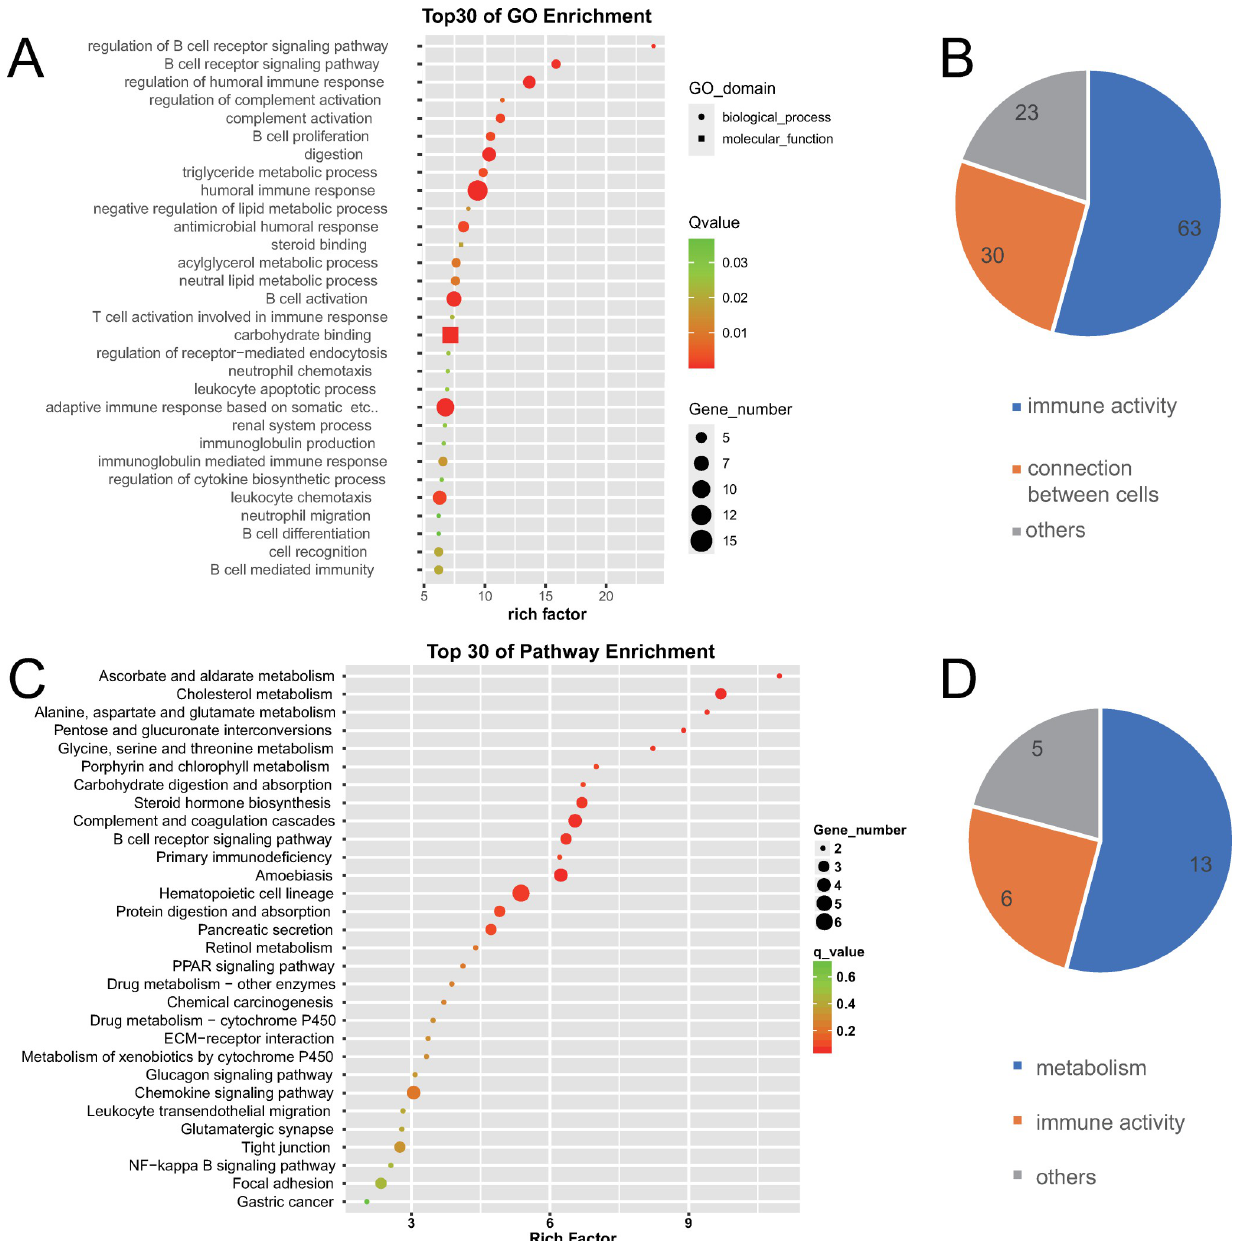
Fig 5. GO and KEGG enrichment analysis of differentially expressed mRNAs between gallbladders with chronic inflammation and early GBC. (A) The top 30 GO terms with a high degree of enrichment. The shapes of icons represent different GO categories, the size represents the number of differentially expressed genes contained by this GO term, the color depth represents the size of the q-valueand the X axis indicates the value of the rich factor. (B) The 116 GO terms with q-value � 0.05 were further classified. Numbers on the graph represent the number of GO terms corresponding to the category. (C) The top 30 KEGG terms with a high degree of enrichment. The size of icons represents the number of differentially expressed genes contained by this KEGG term, the color depth represents the size of q-value, and the X axis indicates the value of the rich factor. (D) The 24 KEGG terms with p-value � 0.05 further classified. Numbers on the graph represent the number of KEGG terms corresponding to the category. expressed genes preliminarily. Further cluster analysis revealed that this 116 GO terms were distinctly related to immune activity (63 terms) and connection between cells (30 terms), which further indicate the highlighted gene function categories of differentially expressed genes. The top three enriched terms were regulation of B cell receptor signaling pathway,